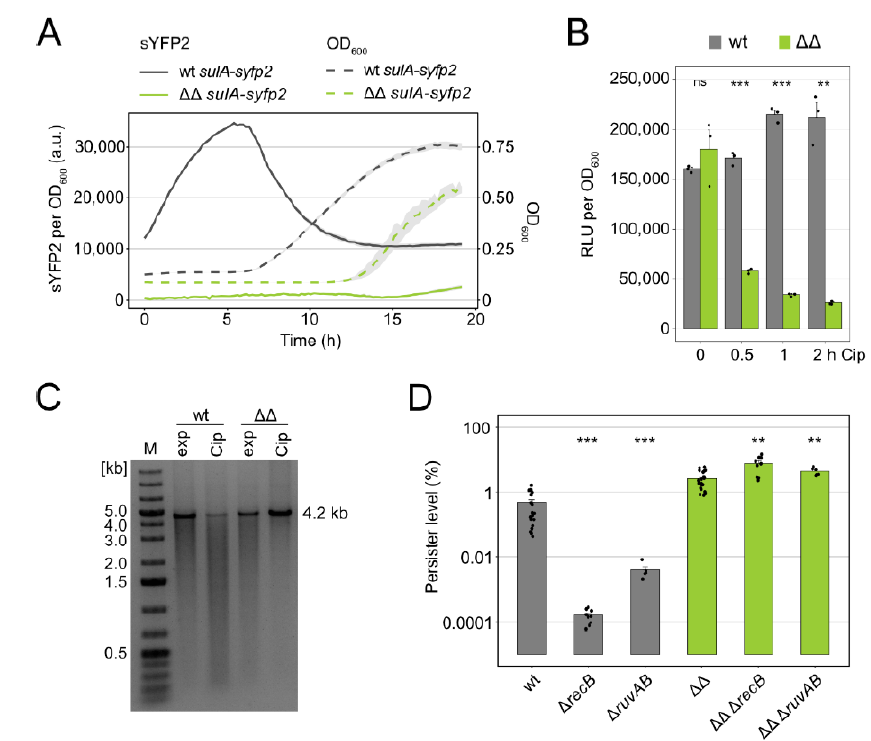
Figure 1. DSB repair is not crucial for persisters of mutant ∆ 1-41 ∆ istR . ( A ) SOS induction during recovery. Strains were treated with Cip (0.1 µ g mL − 1 ; 10 × MIC) for two hours during the exponential phase (OD 600 of ~0.4). Cip was removed by washing, cells were resuspended in a fresh medium and transferred to 96-well plates. Growth (dotted lines) and sYFP2 fluorescence from chromosomal sulA-syfp2 fusions (solid lines) were monitored in a microplate reader. Fluorescence measurements were normalized to the corresponding OD 600 measurements. Data represent the mean (colored lines) and SEM (grey ribbon; n = 3). ( B ) ATP levels were determined by a luciferase-based assay upon treatment with Cip (0.1 µ g mL − 1 ; 10 × MIC). Relative light units (RLU) were background-corrected and normalized to OD 600 . Bars represent the mean ( ± SEM; n = 3). A pairwise t -test was performed to compare wt and ∆∆ at each time point (ns: not significant, ** p < 0.01, *** p < 0.001). Black dots indicate the results of individual biological experiments. ( C ) Linearized plasmid DNA was analyzed on an agarose gel. Plasmid DNA was extracted from cultures in exponential phase (exp, OD 600 of ~0.4) and after two hours of Cip treatment (0.1 µ g mL − 1 ; 10 × MIC). A marker (M) in kb is shown on the left-hand side. ( D ) Colony counts were determined before and after six hours of Cip treatment (1 µ g mL − 1 ; 100 × MIC) to calculate persister levels. Bars represent the mean ( ± SEM; n ≥ 6). A pairwise t -test was performed to compare recB and ruvAB deletions to their parental strains (** p < 0.01, *** p < 0.001). (wt: wild type MG1655; ∆∆ : ∆ 1-41 ∆ istR ). Black dots indicate the results of individual biological